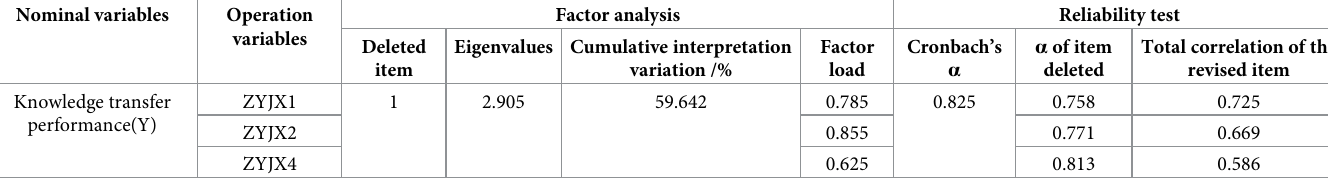
Table 11. Factor analysis and reliability test scale results of the knowledge transfer performance.